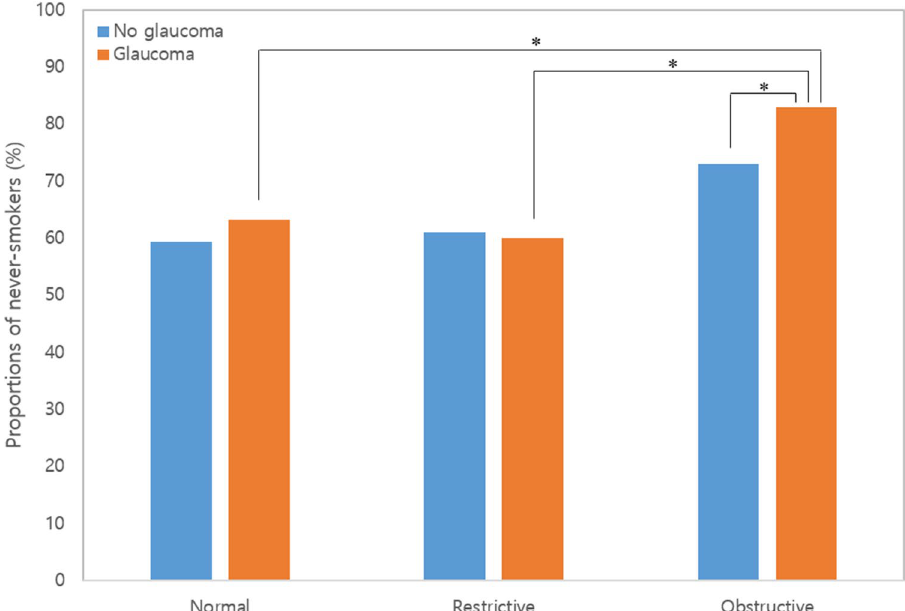
Figure 3. Comparisons of never-smoker proportions in women based on pulmonary function types and the presence of glaucoma. The proportions of never-smokers were significantly higher in women with COPD and glaucoma when compared to women with COPD but no glaucoma. The differences were also statistically significant when compared to women with glaucoma who had restrictive or normal lung function. The asterisk indicates a P value < 0.05.